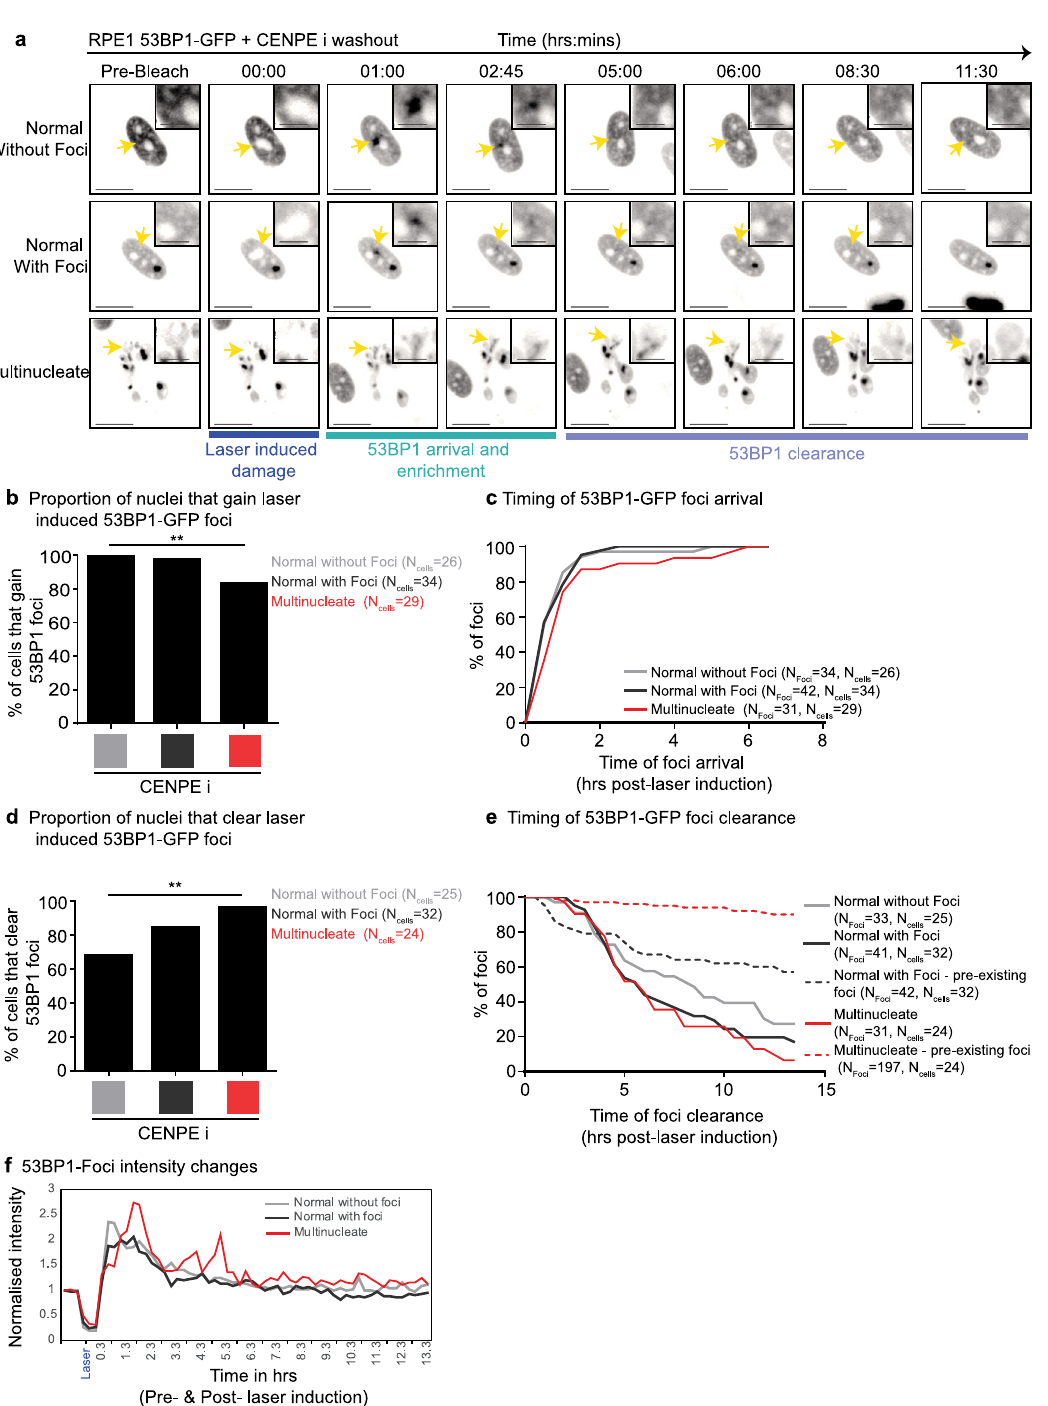
Fig. 3 MADD is not resolved despite intact DDR signalling in multinucleate cells. RPE1 H2B-RFP 53BP1-GFP cells were treated with CENPEi for 24 h, washed and imaging initiated. One laser induced bleach/damage site in each nucleus was tracked. a Representative pre-bleach, bleach (at 00:00) and post-bleach images of nuclei — either normal nuclei without pre-existing 53BP1 foci, normal nuclei with pre-existing 53BP1 foci or multinucleate nuclei with 53BP1 foci. Yellow arrows indicate sites of bleaching and are highlighted in crops. Scale 15 μ m; insets 5 μ m. b Graph shows the proportion of nuclei that gain 53BP1-GFP foci at the site of laser-induced damage, for multinucleate, normal with pre-existing foci and normal nuclei without pre-existing foci. N indicates the number of cells, from across 3 independent repeats. Statistical signi fi cance was assessed using a proportions test with a 95% con fi dence interval. ** indicated p < 0.05. c Graph shows timing, post-bleach, of 53BP1-GFP foci arrival at the laser bleach site. d Quanti fi cation of the proportion of nuclei that cleared laser-induced 53BP1-GFP foci, for normal and multinucleate cells. Statistics was assessed using a proportions test with a 95% con fi dence interval. ** indicates p < 0.05. e Graph shows the timing of 53BP1-GFP foci clearance after bleach time, for foci induced at the bleach site (solid lines) and foci existing prior to laser bleach (dashed lines). N indicates the number of foci and cells analysed. f Graph shows changes in 53BP1-GFP foci intensity at laser- induced damage site in cells shown in Fig. 3a. 53BP1-GFP intensities were normalised using pre-laser damage intensity